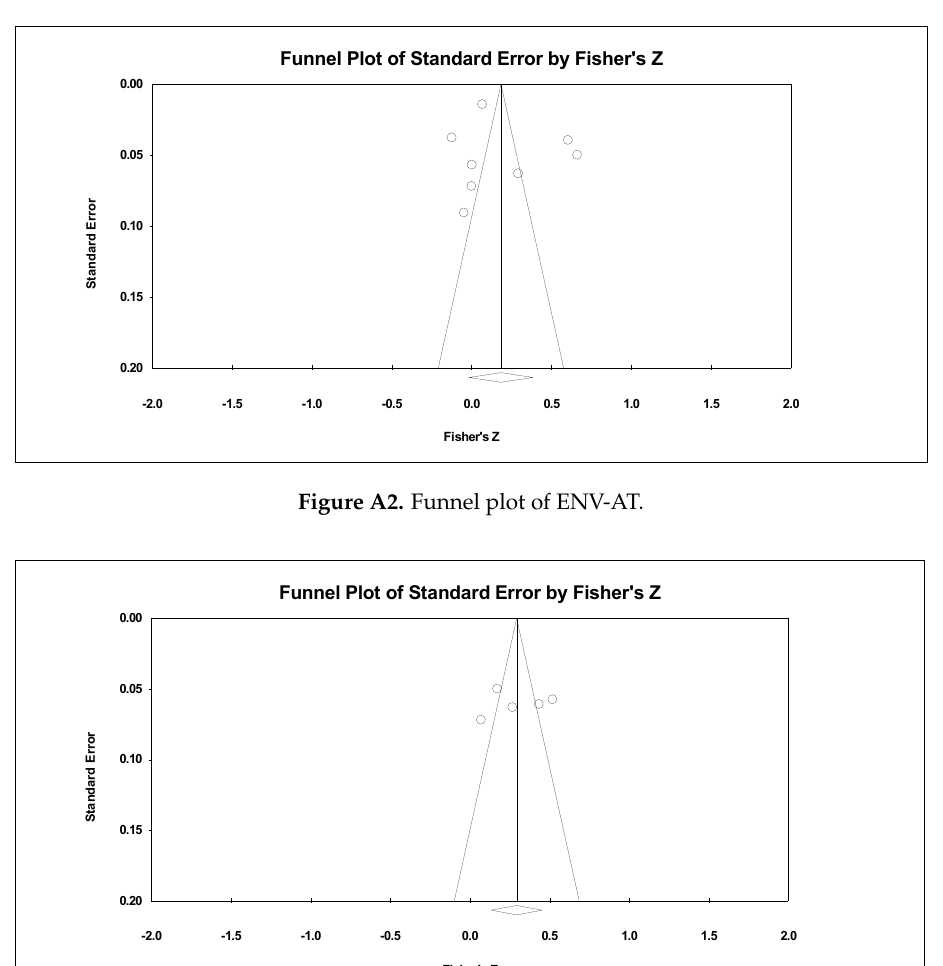
Figure A3. Funnel plot of ENV - SN.